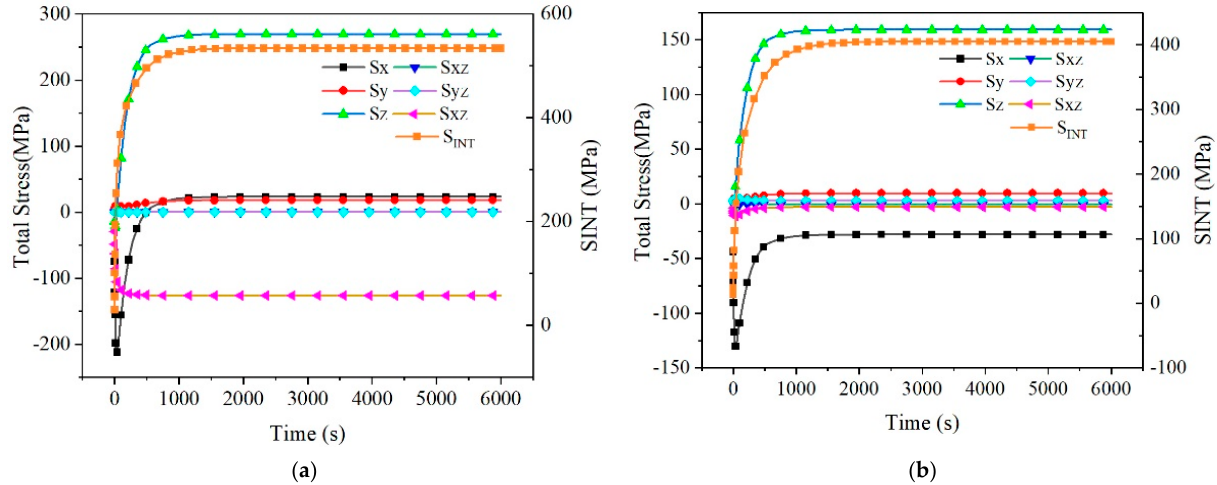
Figure 13. Transient thermal stress (total stress and S int ) response of evaluation paths based on FEM. ( a ) Section A-60 ( b ) Section B-270.